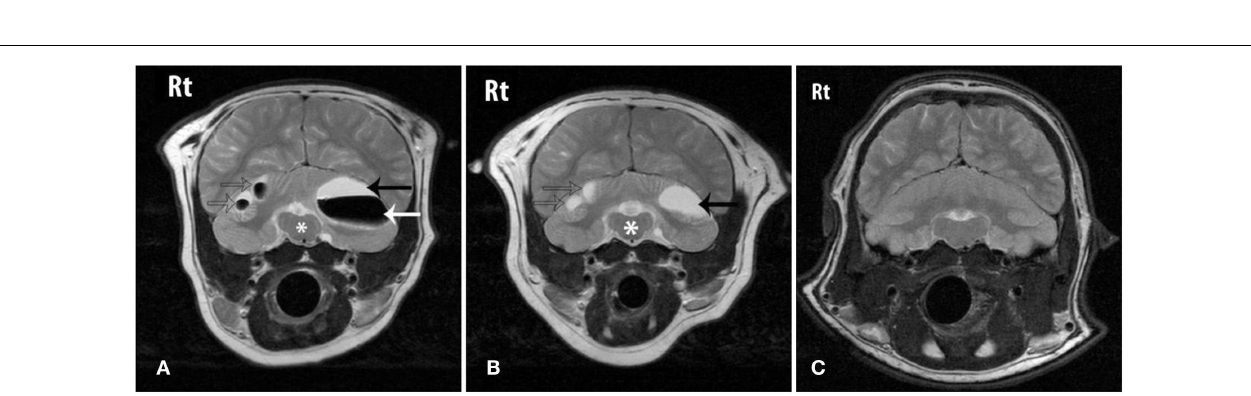
The mass effect of the lesions is causing distortion of the brainstem (*). (B) On follow-up MRI the lesions (arrows) shown in (A) have reduced in size, normalizing the appearance of the brainstem (*).The previously seen gas has been resorbed and the lesions now contain only fluid. (C) An image at the same level from a normal sea lion at the same